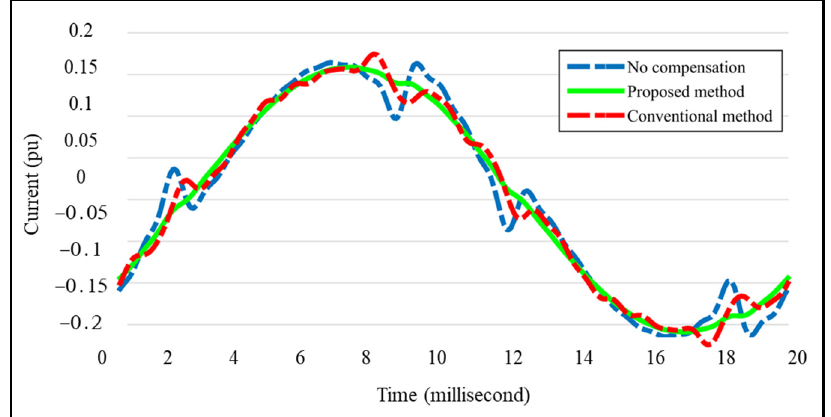
Figure 18. Voltage THD values before and after allocation of active filters.